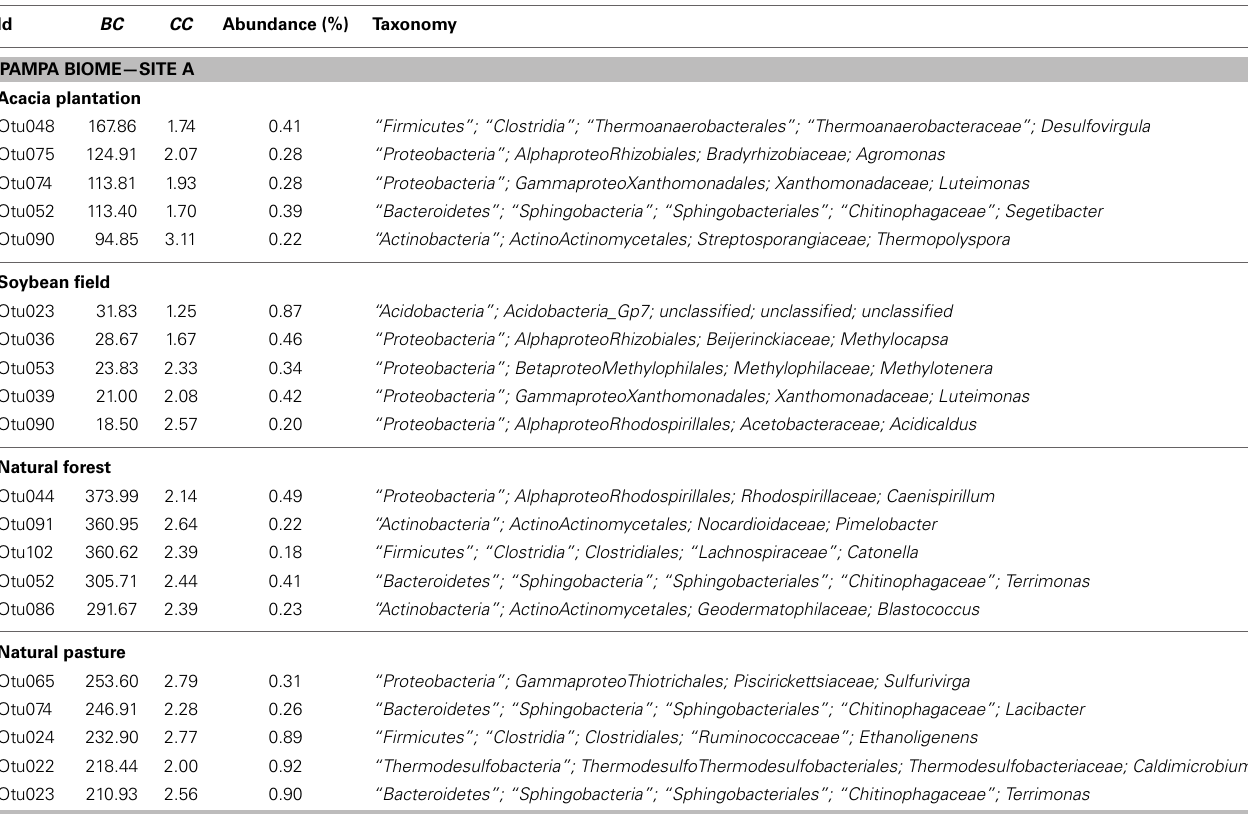
Table 3 | The five genera selected by the greatest values of Betweenness Centrality (BC) found in each of the sampling